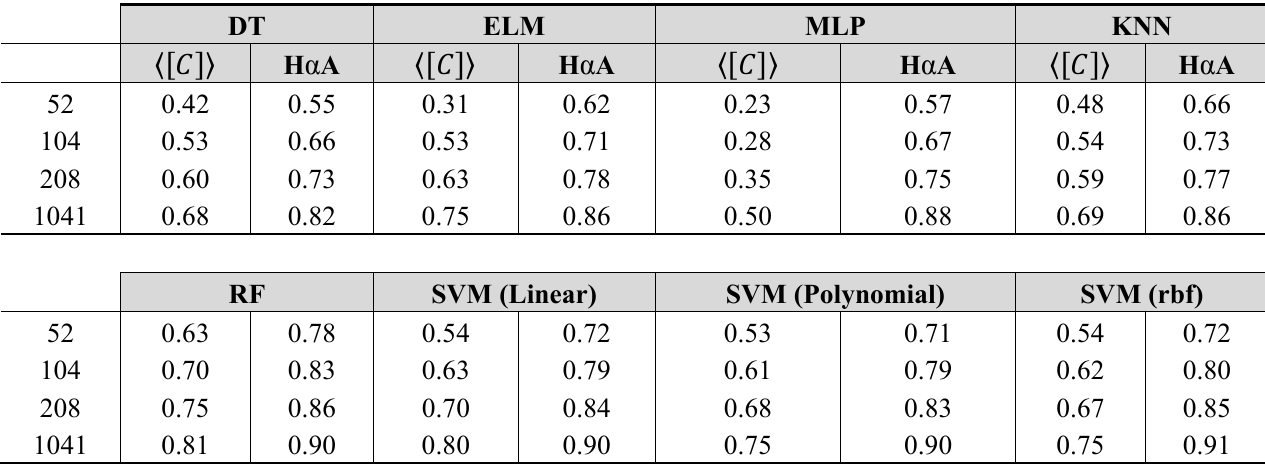
Table 1. Results over the covariance matrix 〈(cid:4670)(cid:1829)(cid:4671)〉 and H α A features with various supervised